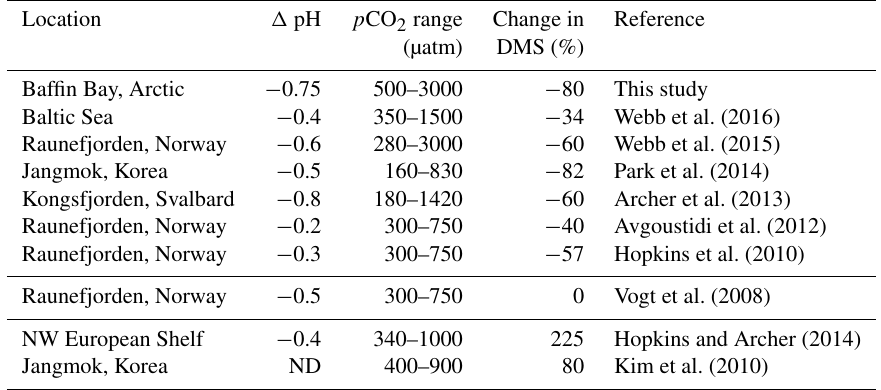
Table 6. Changes in dimethyl sulfide (DMS) concentrations reported in previous CO 2 perturbation experiments in mesocosms or microcosms. (cid:49) pH represents the change in pH T applied in each experiment. In our study, pH T ranged from 7.94 to 7.16 at day T1. ND: no data. The experiment was carried out in the coastal waters of Korea (Jangmok, 34.6 ◦ N and 128.5 ◦ E) Location (cid:49)